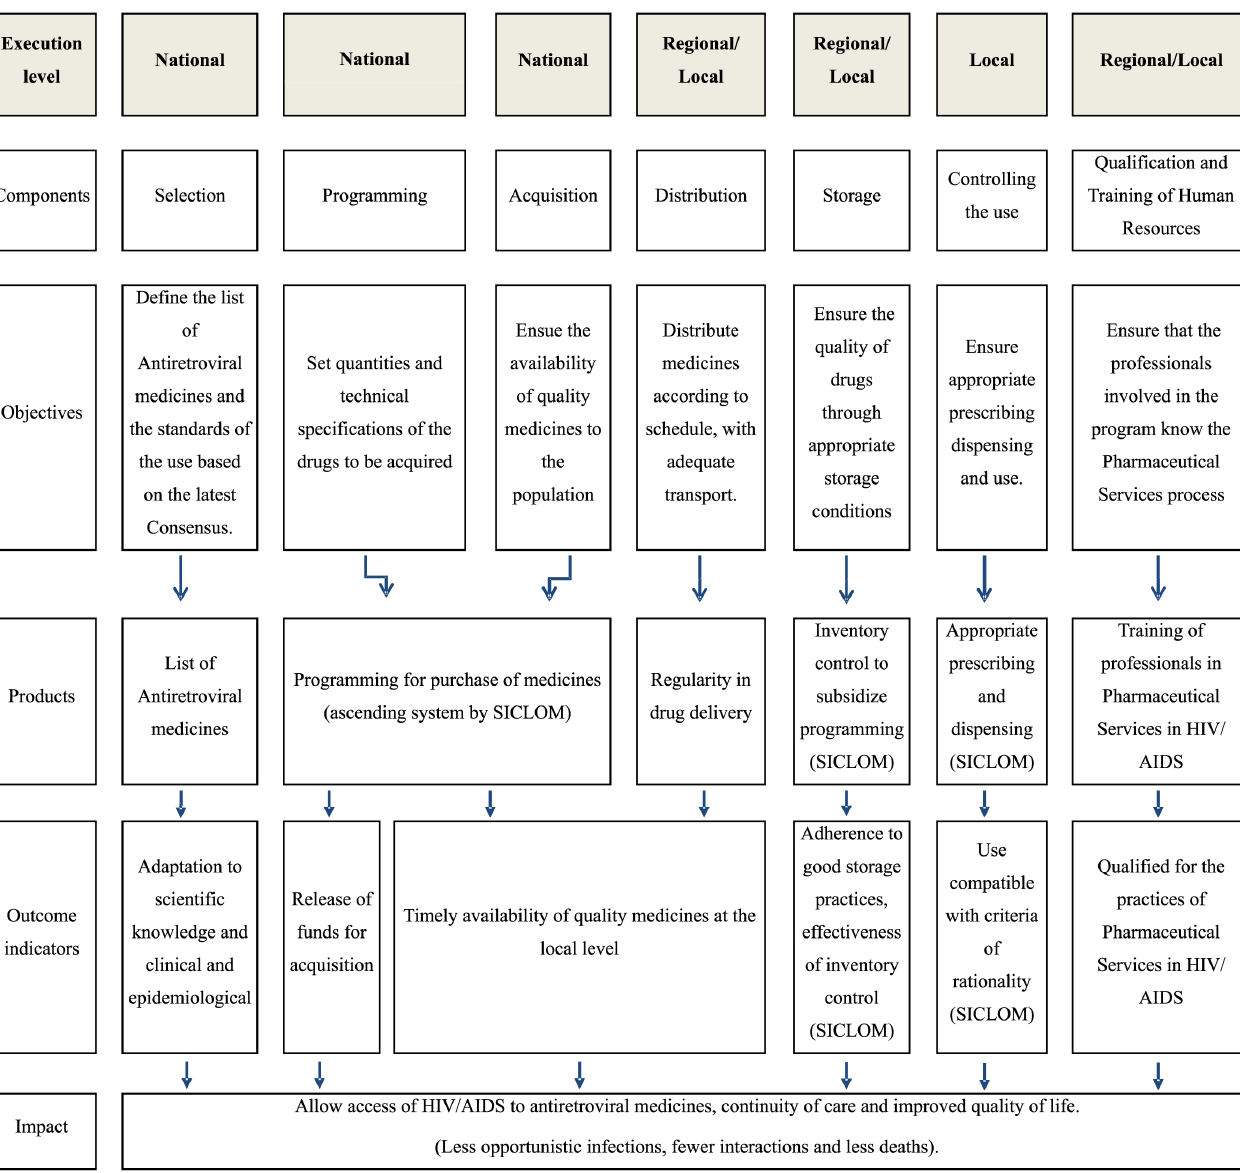
FIGURE 1 - Logic Model suggested for Pharmaceutical Services in HIV/AIDS in city of Niterói. (Adapted from Oliveira et al. , 2002 and Cosendey, Hartz, Bermudez,